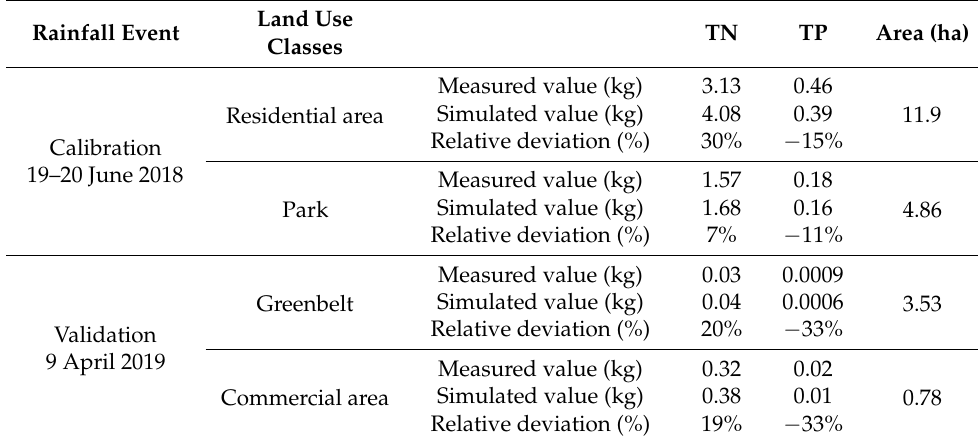
Table 4. Relative deviation between simulated value and measured value.